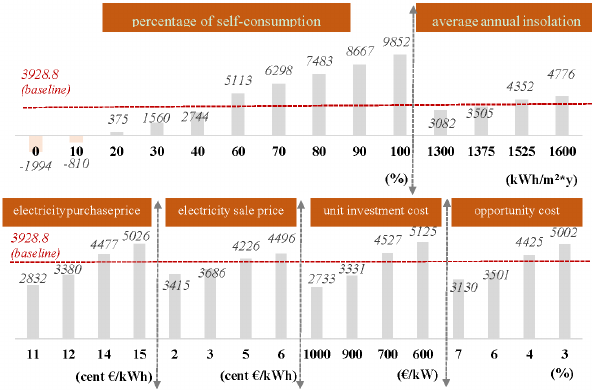
Figure 5. Sensitivity analysis–NPV (k€) for a 5 MW power system.